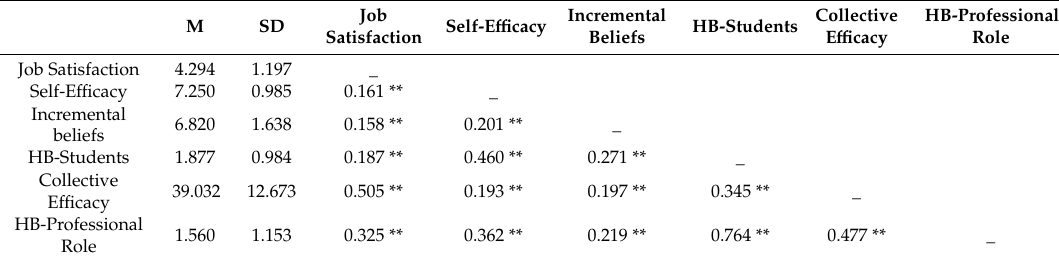
Table 1. Mean, standard deviations, and correlations among